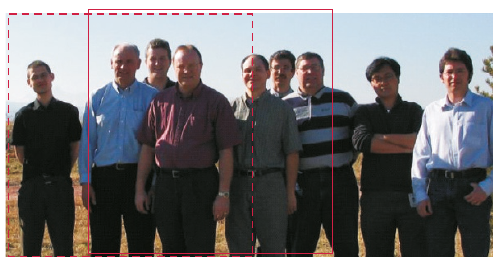
Figure 2: Data reuse in the overlapping regions of the search area data for motion estimation.